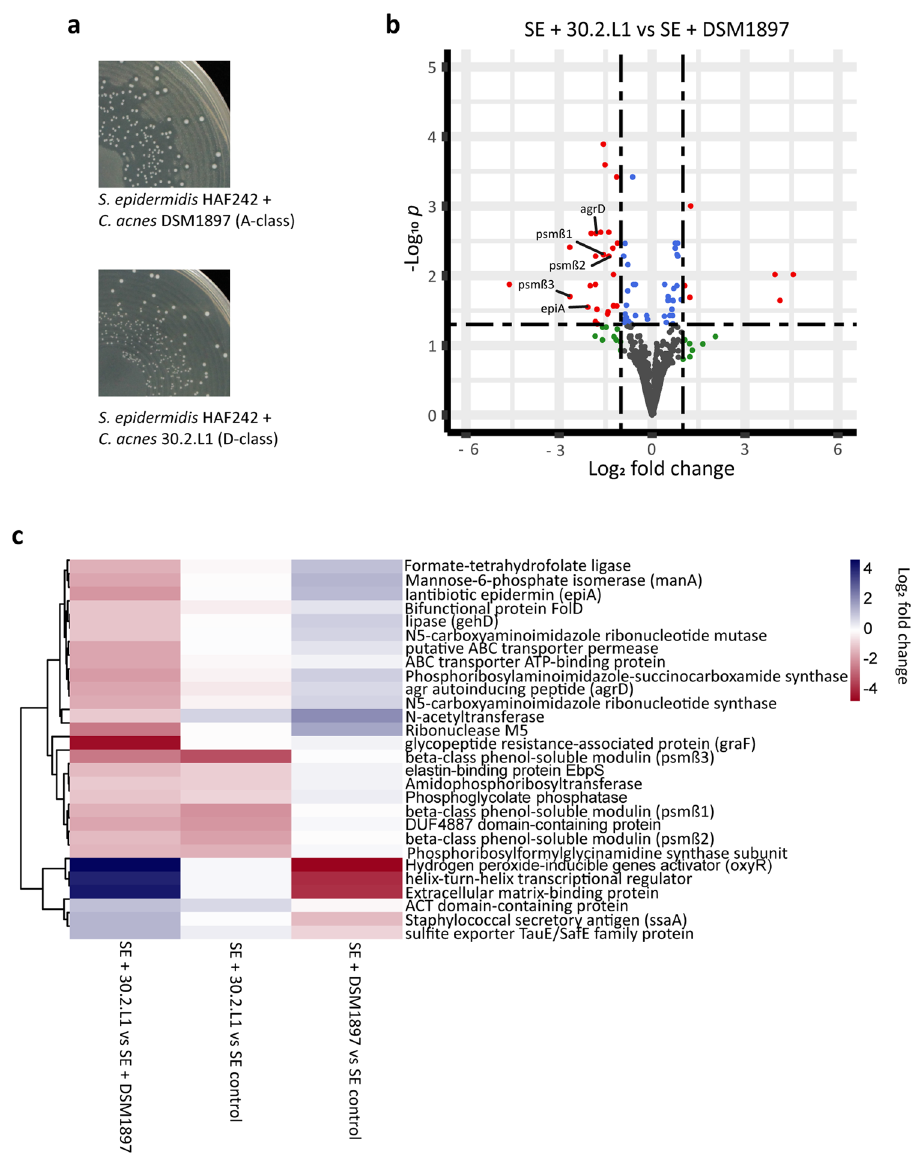
Fig. 6 Differential expression of quorum-sensing regulated genes in S. epidermidis HAF242 co-cultured with C. acnes 30.2.L1 (D-class) and C. acnes DSM1897 (A-class). a Colonies of S.epidermidis HAF242exhibit inhibition zones on a lawn of C.acnes DSM1897 (A-class) but not ona lawn of C.acnes 30.2.L1 (D-class). b Differential gene expression of S. epidermidis HAF242 (SE) grown in the two co-cultures (co-culture with C. acnes 30.2.L1 (D-class) versus co- culture with C. acnes DSM1897 (A-class)) (FDR-adjusted p -value, cut off: p ≤ 0.05 and fold-change >2 or < − 2). c Heat map of all differentially expressed genes in S. epidermidis HAF242 when grown in the two co-cultures ( fi rst column; genes encoding hypothetical proteins were excluded). Gene expression was also compared between S. epidermidis grown in co-culture (second and third columns) versus S. epidermidis grown in monoculture ( “ SE control ” ). skinsample:1:1and1:100) in0.9%NaClsolution.Cultivationwasdonebyplatingon Columbia agar with 5% sheep blood; agar plates were incubated at 37°C for 24h. CFU count was determined with an automatic colony counter (IUL). Up to fi ve coloniesthatresembled staphylococcibasedoncolony sizeand colourwererandomly picked of each plate and pure cultures were obtained by sub-cultivation on the same agar. Each isolate (572 isolates in total) was assigned to species level by MALDI-TOF mass spectrometry (Supplementary Data 7).